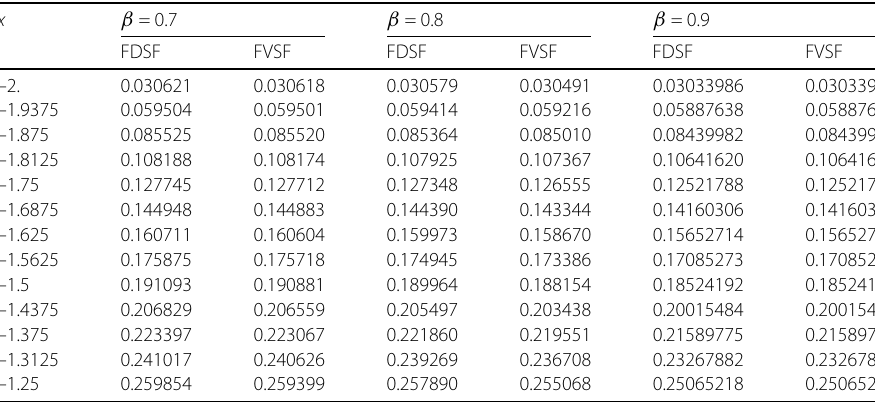
Table 3 Numerical results for Example 2 with varying β at time t = 1, fixed h = 0.0625 and τ = 0.01